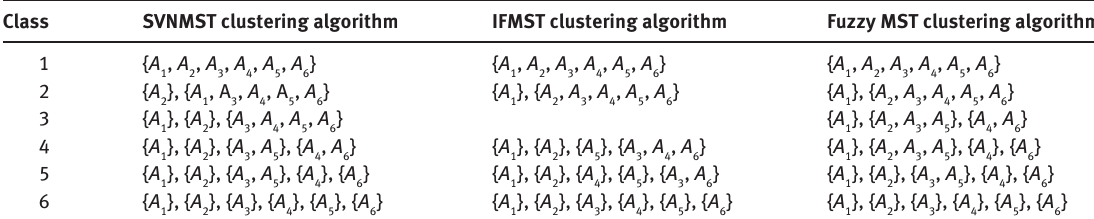
Table 5. Clustering Results of Three Kinds of Clustering